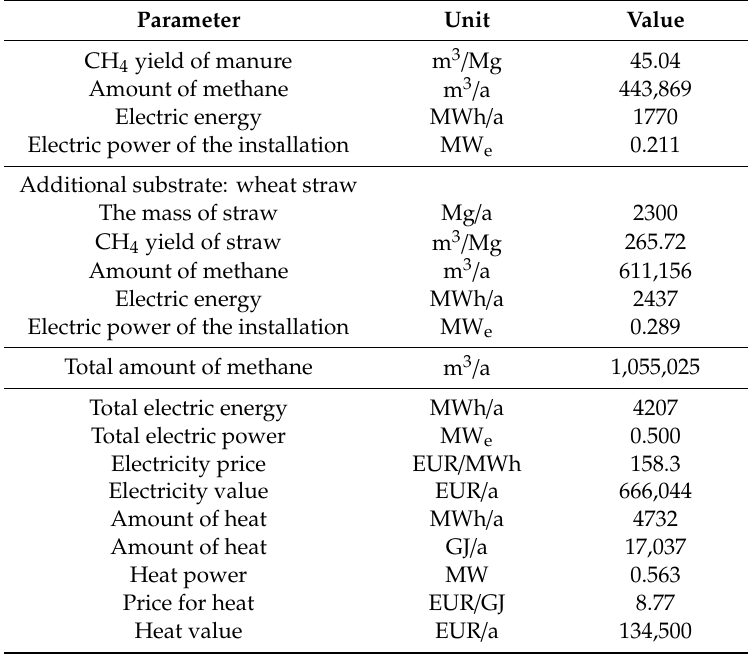
Table 3. Energetic aspects of the biogas plant in the analyzed dairy